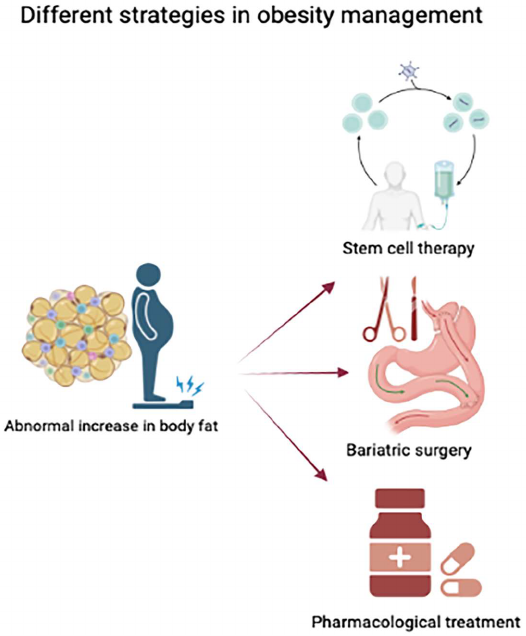
Figure 2. Some therapeutical approaches for management of obesity. Created with